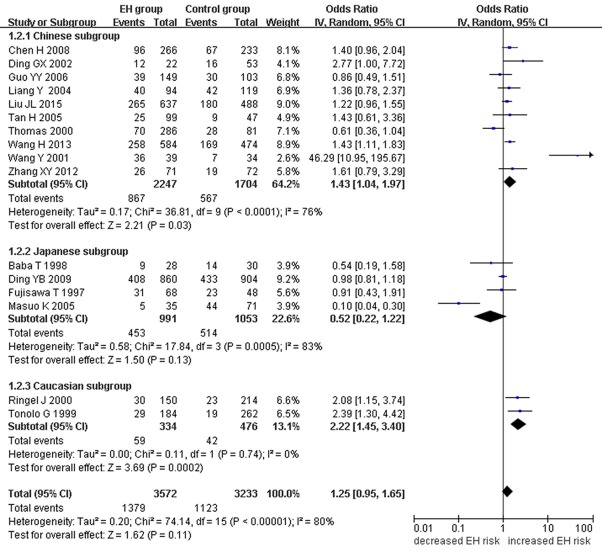
Forest plot of EH associated with ADRB3 gene Trp64Arg polymorphism under a heterozygous genetic model (TA vs. TT).